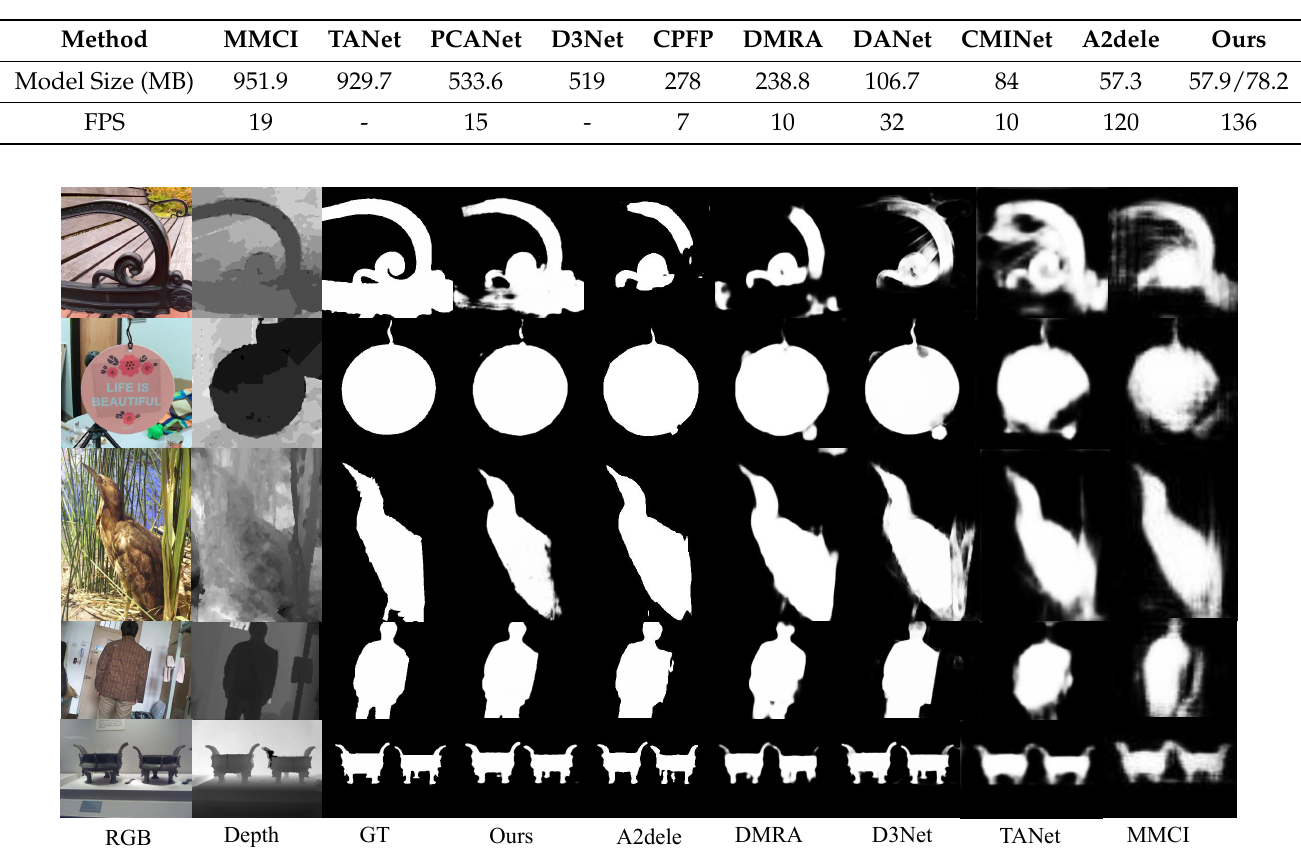
Table 2. The model size and inference speed of different methods.